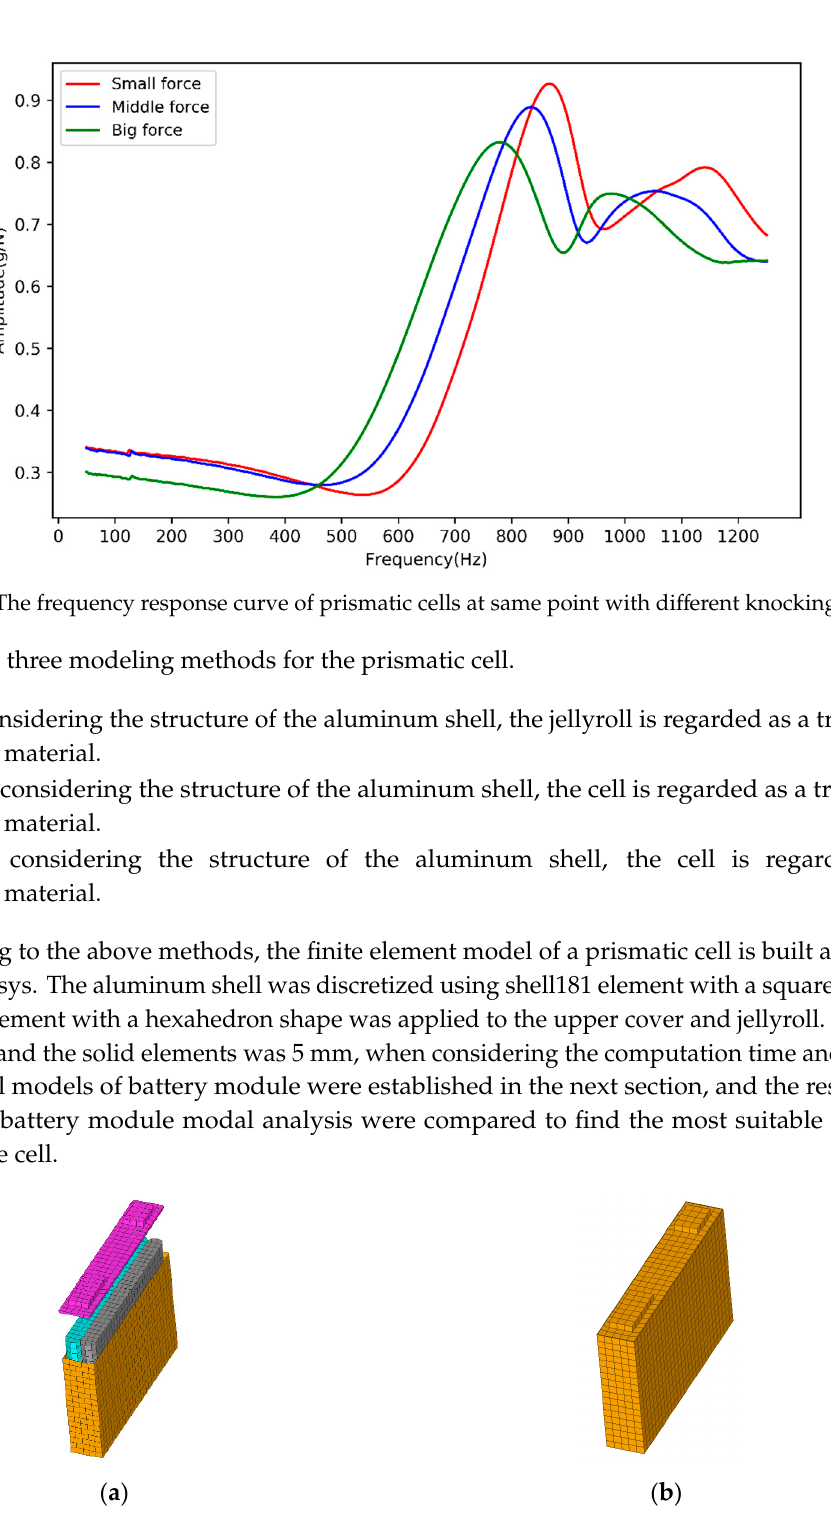
1 23 Figure 5. Composition of the prismatic cell. The frequency response curve of the same point changed with the size of the knocking force.